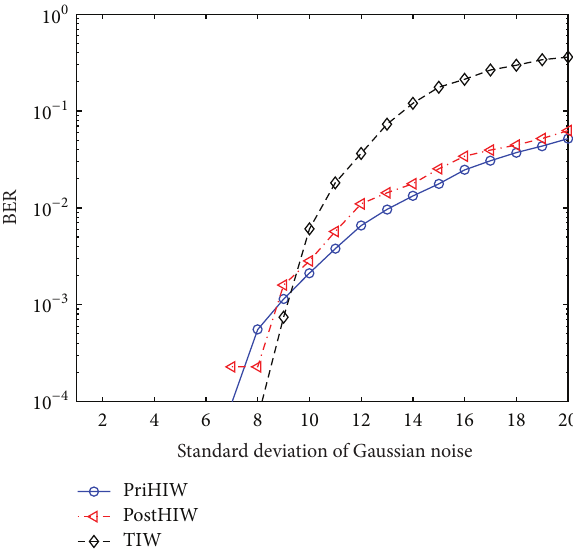
Figure 9: Performance comparison for the PriHIW, PostHIW, and TIW against